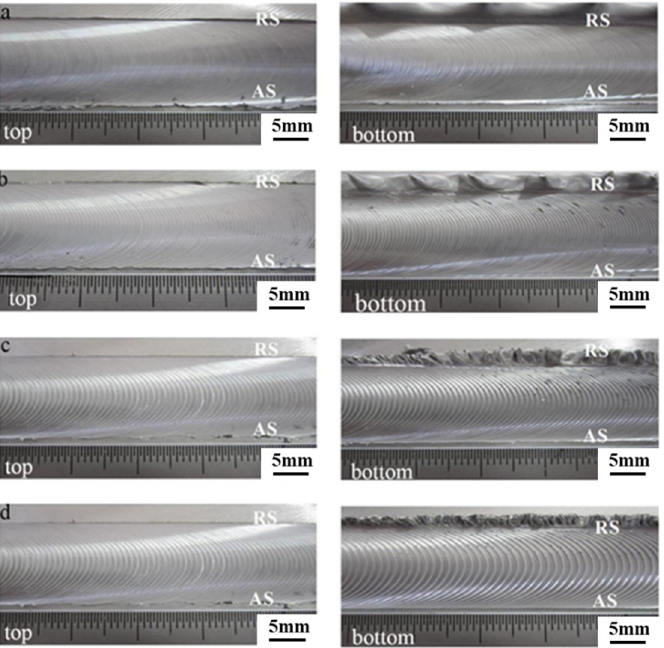
Figure 3. Surface appearance morphology of the joint welded at the welding speed of: ( a ) 150 Figure 3. mm/min; ( b ) 250 mm/min; ( c ) 350 mm/min and ( d ) 450 mm/min. ( a ) 150 mm/min; ( b ) 250 mm/min; ( c ) 350 mm/min and ( d ) 450